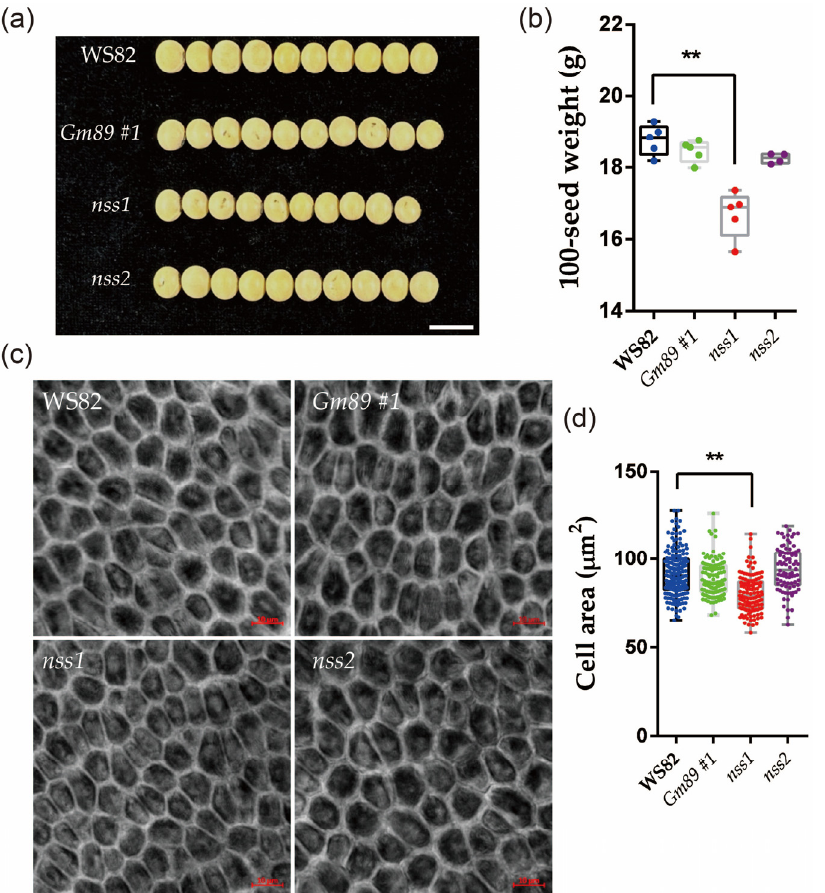
Figure 6. Comparative analysis of phenotypes between mutants and wild-type seeds. ( a ) The seed size decreased in width in nss1 mutant (10 seeds are shown in each line); ( b ) the 100-seed weight was significantly decreased in the nss1 mutant; ( c ) the integument cells in mutants and wild-type seeds. Bars = 10 μ m; ( d ) the cell area of mutants and wild-type seeds. Asterisks indicate a significant difference according to Student’s t -test (**, p < 0.01).